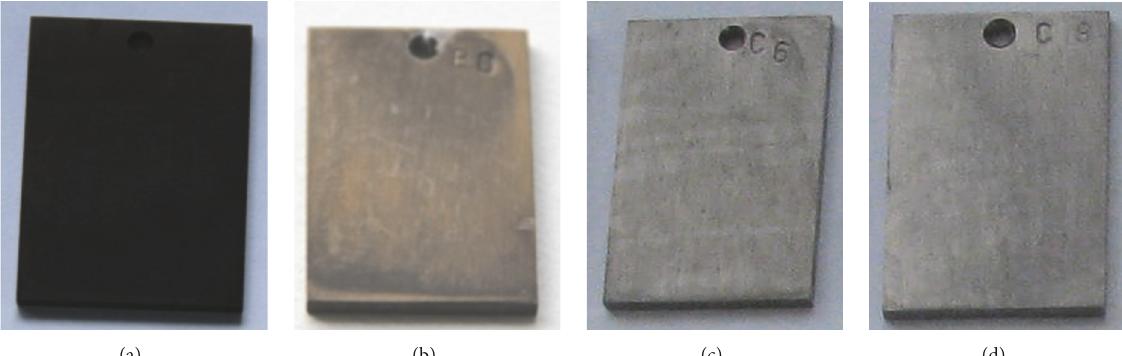
Figure 6: The morphologies of (a) preoxidation 304L SS and ((b), (c), and (d)) preoxidation 304L SS carrying out AP-N decontamination of 1 ∼ 3